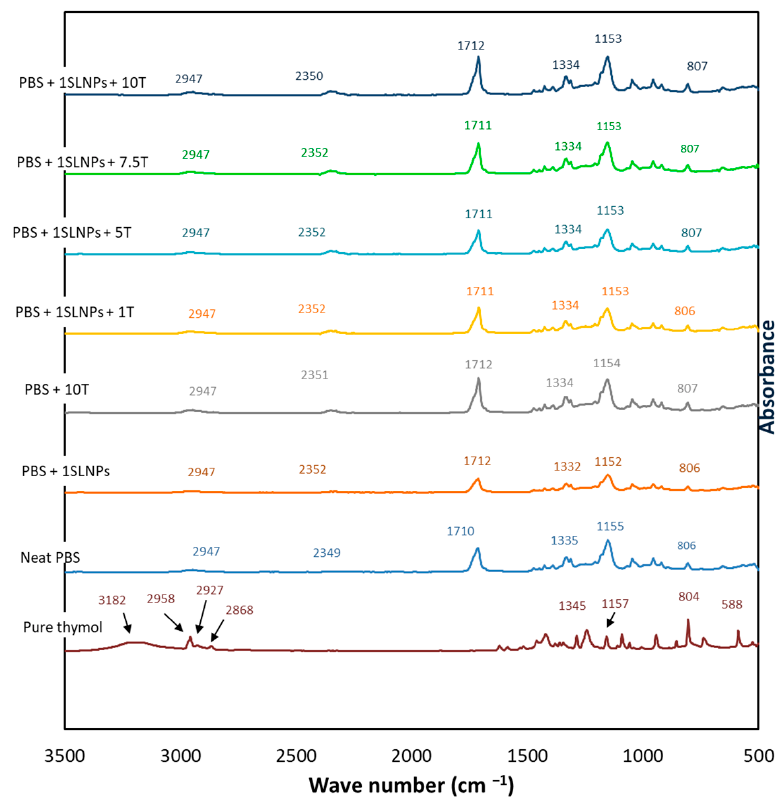
Figure 2. FTIR spectra of neat PBS, pure thymol, and PBS composites.